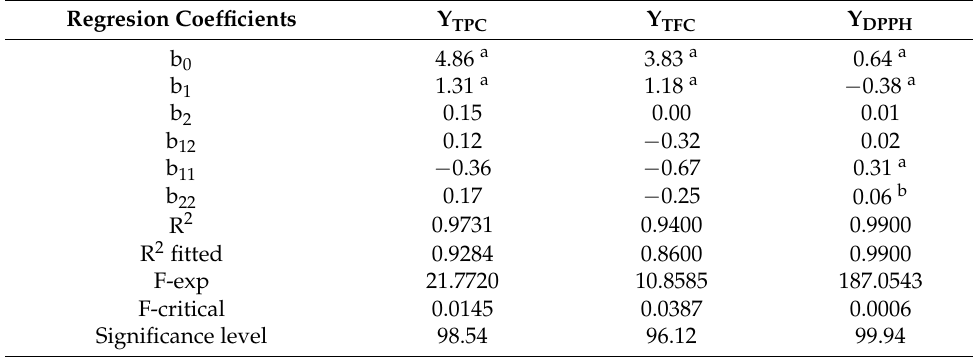
Table 5. Regression coefficients and statistical parameters of the experimental